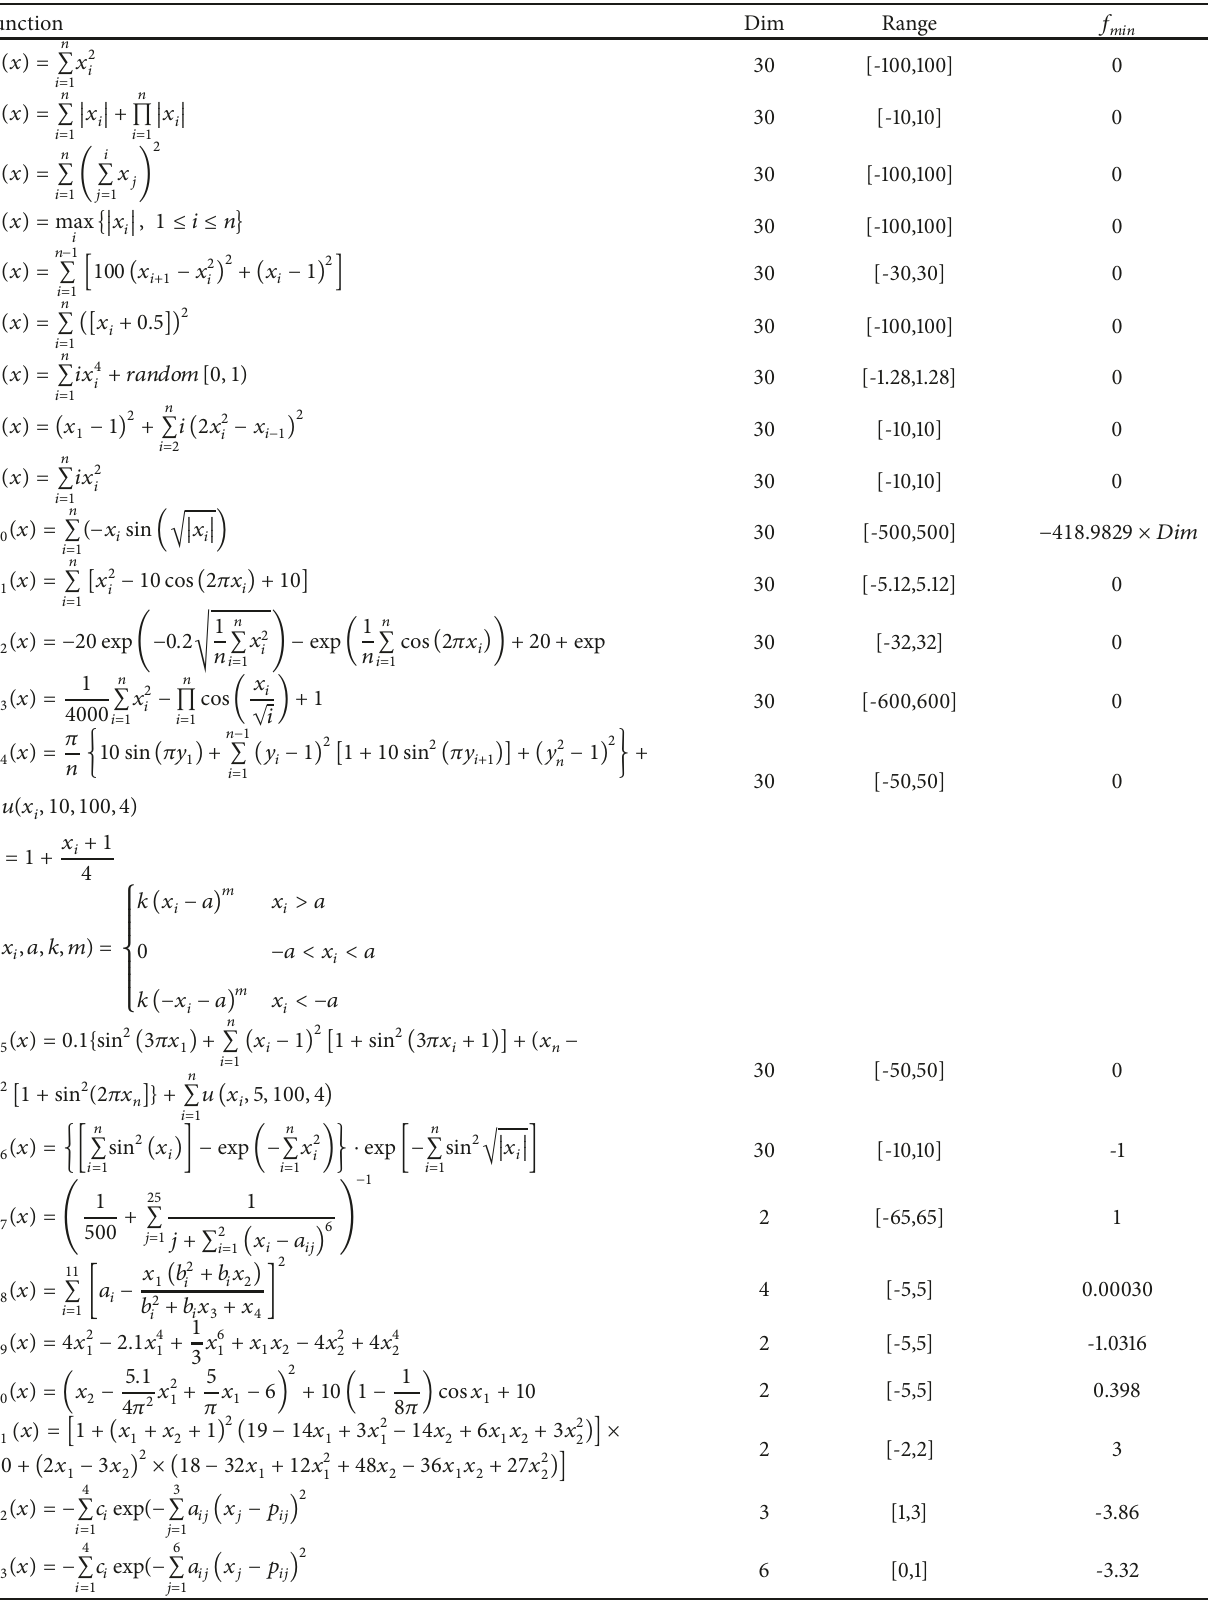
Table 1: Description of benchmark